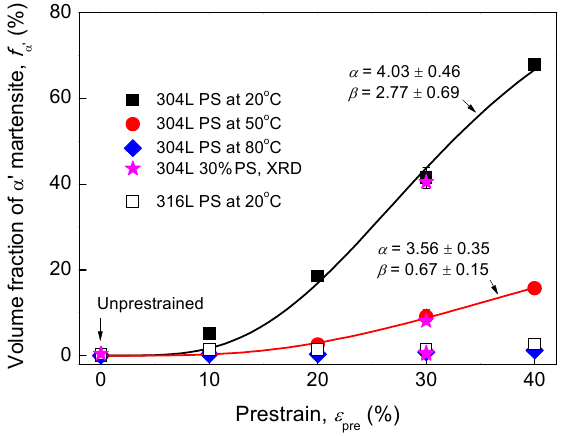
Figure 1. Volume fraction of α′ obtained by Feritscope for 304L and 316L specimens un-prestrained and prestrained (PS) at different temperatures. The fitting curves based on the relation proposed by Olson and Cohen [39] are also depicted: f α (cid:48) = 1 − exp , where n is a fixed exponent having a value of 4.5, and α and β are temperature-dependent parameters, which decrease with increasing temperature, in agreement with [39].